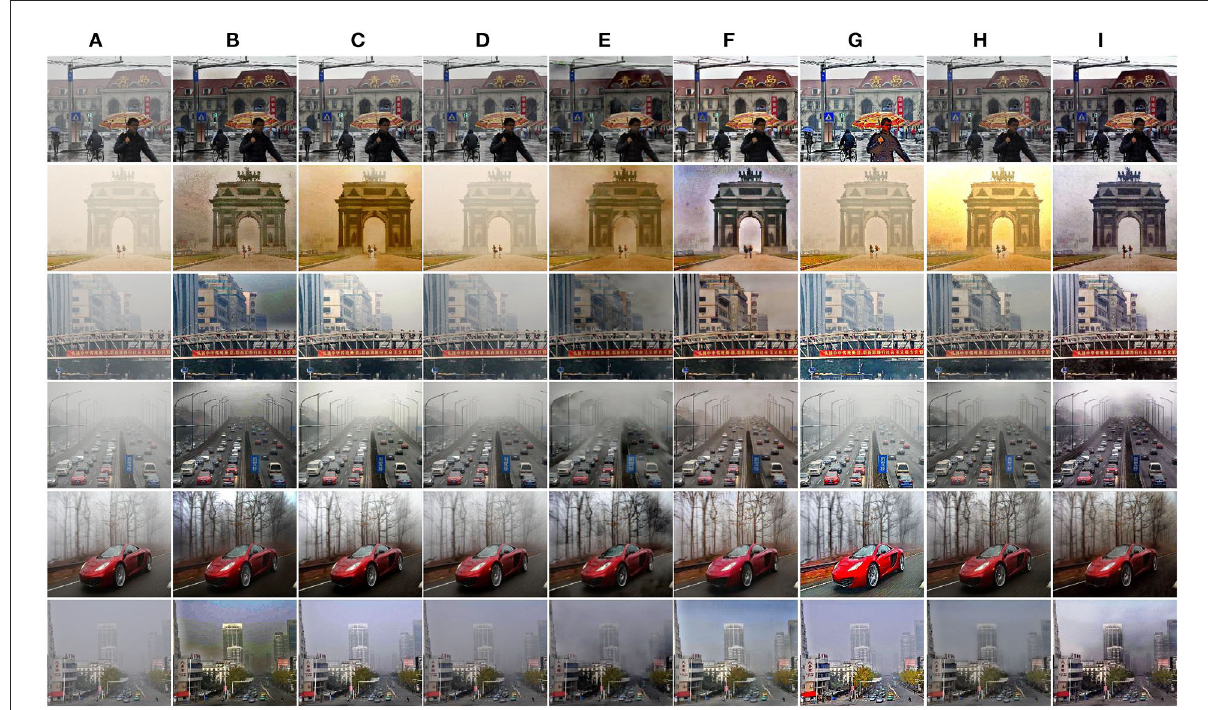
FIGURE6 Qualitative comparisons on real-world images in URHI. (A) Hazy. (B) DCP. (C) DCPDN. (D) MSBDN. (E) FFA. (F) DA. (G) PSD. (H) RefineD. (I) Ours.